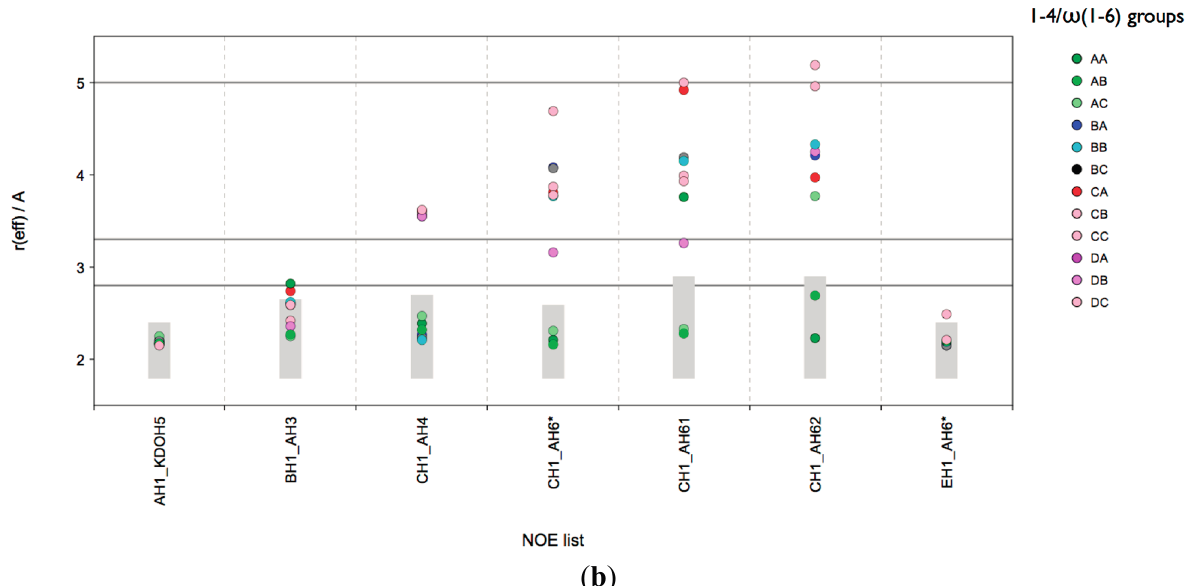
Figure 3. lgt1/4 Δ OS: CAT analysis of r eff for conformational state groups. Combined states of the glycosidic linkages β - D -Glc p -(1-3)- α - D -Glc p ( B - A ) and β - D -Glc p -(1-4)- α - D -Glc p ( C - A ) ( a ); β - D -Glc p -(1-4)- α - D -Glc p ( C - A ) and ω torsion of β - D -Glc p -(1-6)- α - D -Glc p ( E - A ) ( b ). The horizontal lines indicate the distance limits for classification into strong ( ≤ 2.8 Å), medium ( ≤ 3.3 Å) and weak ( ≤ 5.0 Å) NOEs. The grey boxes indicate the range [ r vdW , r NOE ].